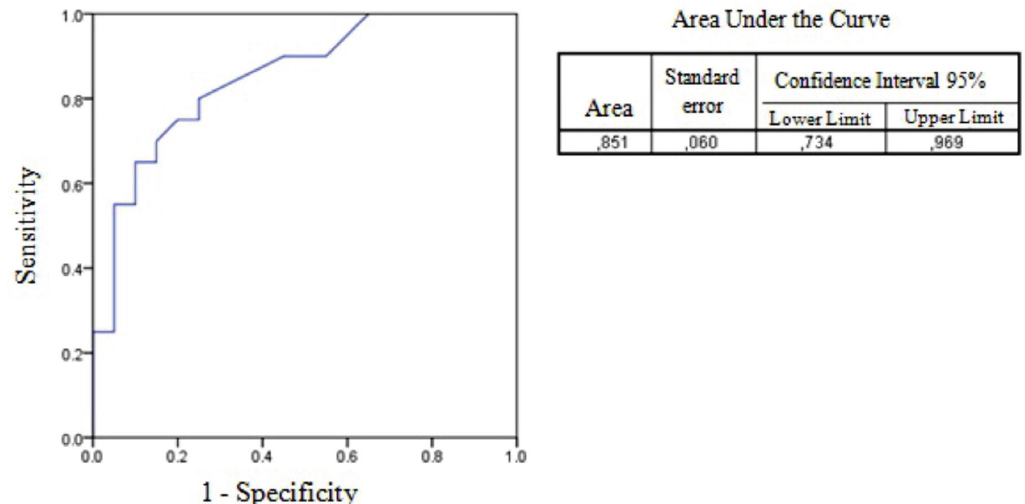
Fig. 1 – ROC curve in the control group to determine the best cutoff point for the variable VPD/VPS in evaluating the patency of composite